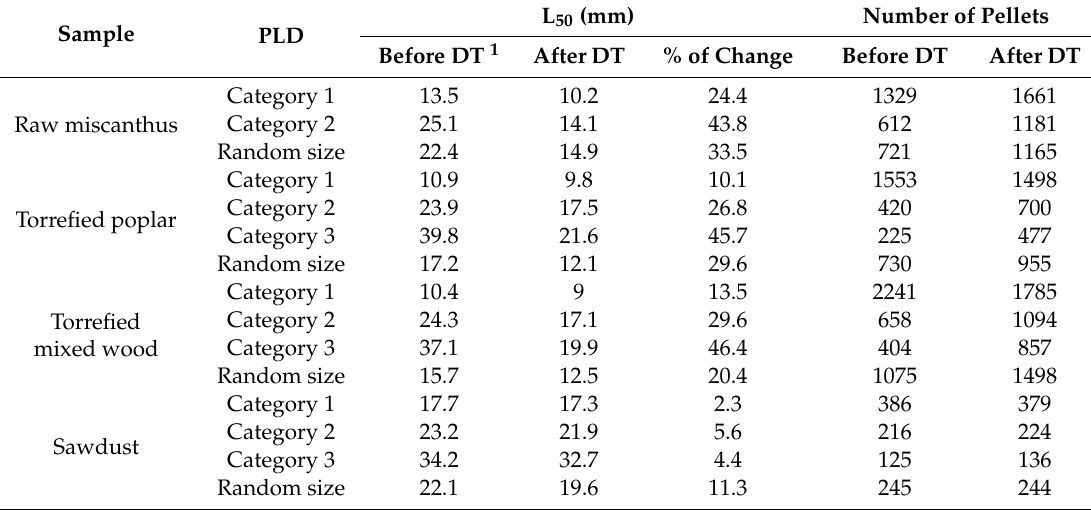
Table 2. Mean pellet length (L 50 ) and the number of pellets before and after mechanical durability test. L 50 (mm) Number of Pellets Sample PLD Before DT 1 After DT % of Change Before DT After DT Raw miscanthus